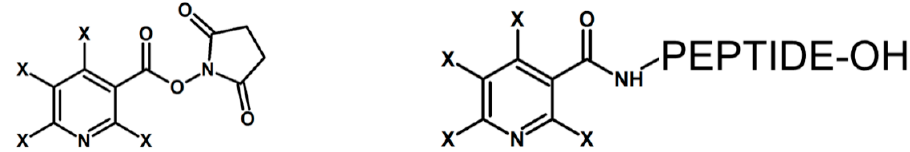
Figure 1. The D4/H4 forms of nicotinyl- N -hydroxysuccinimide (Nic-NHS) developed by James et al. [19] and N -terminally labeled peptide, which can be applied for quantitation. X-H or D atom.